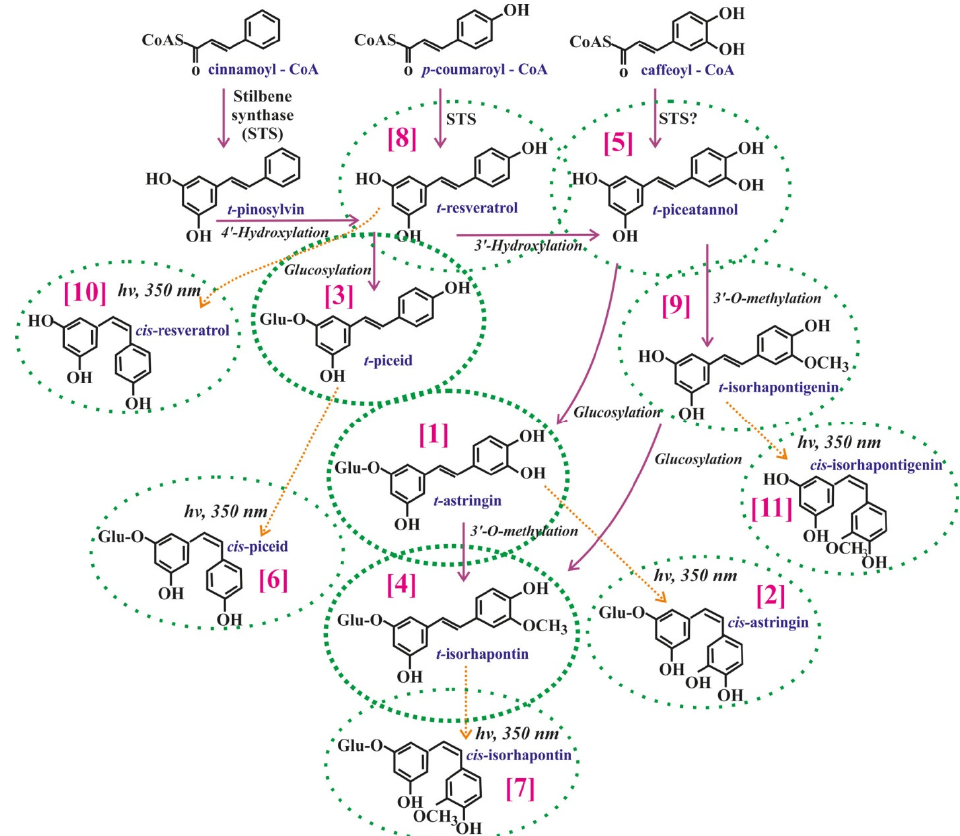
Figure 2. Hypothetical biosynthetic pathway for stilbene formation in Pinaceae [25]. Circles with dotted lines depict 11 stilbenes detected in the needles of spruce Picea jezoensis : trans - and cis - astringin [1,2], trans - and cis -piceid [3,6], trans - and cis -isorhapontin [4,7], trans -piceatannol [5], trans - and cis -resveratrol [8,10], and trans - and cis -isorhapontigenin [9,11]. Trans -astringin [1], trans - piceid [3], and trans -isorhapontin [4] marked with thick dotted lines because the content of